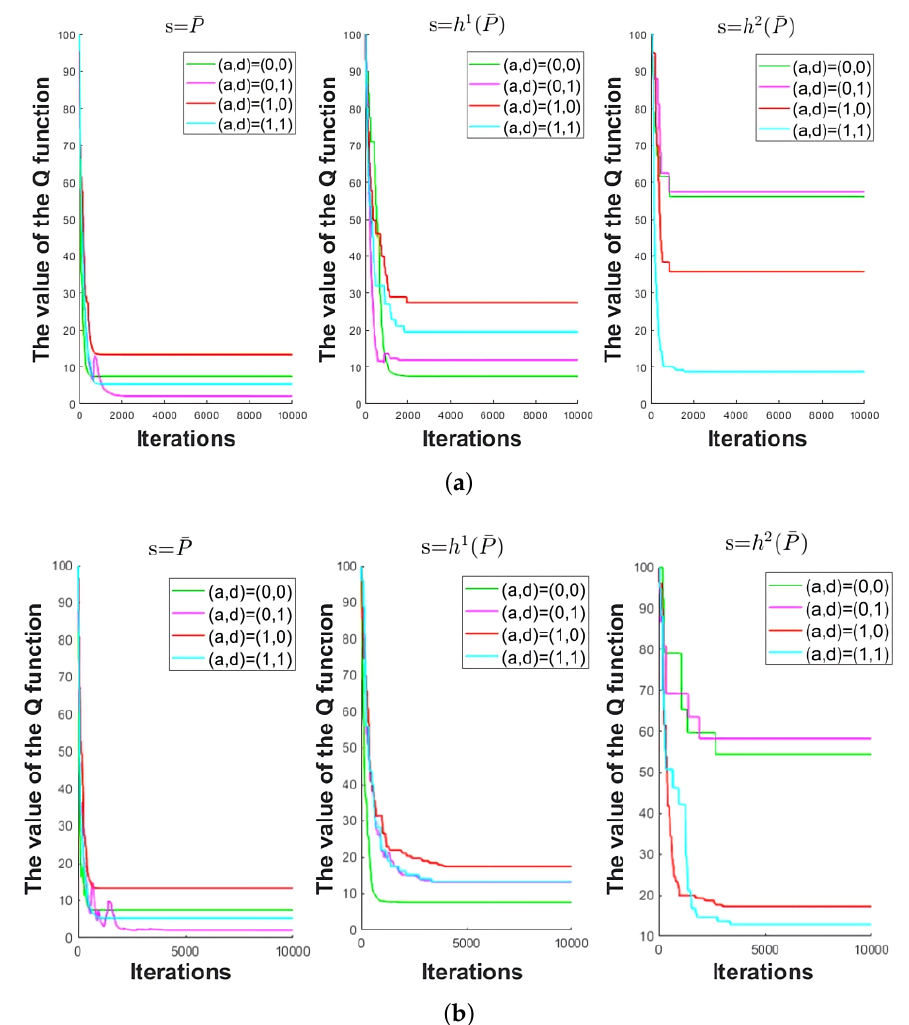
Figure 8. The convergence process of the state-action value Q -function in each state considering the interactive decision game of sensor and attacker. ( a ) The framework of Q -learning; ( b ) The framework of